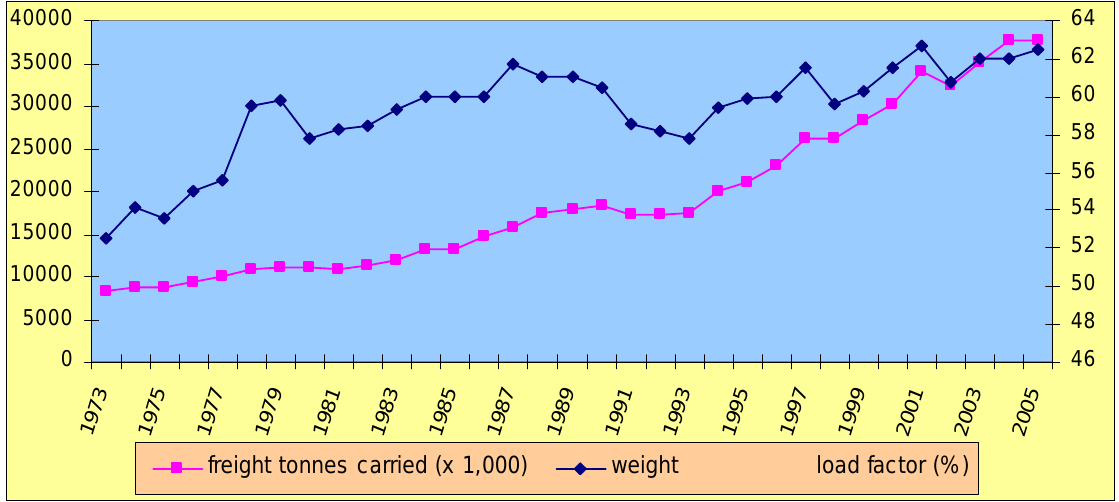
Figure 2. World air transport scheduled services (domestic + international) – freight Source: IATA